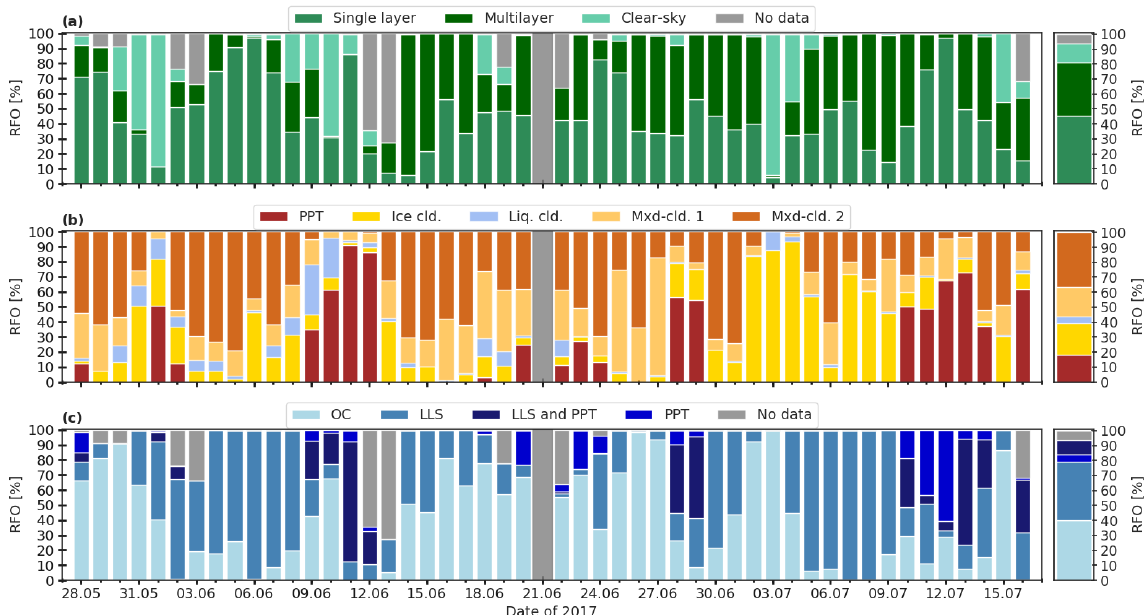
Figure 5. Daily and overall relative frequency of occurrence (RFO) of various cloud characteristics. Panel (a) shows the RFO of clear-sky, single-layer clouds, and multilayer clouds. Panel (b) shows the RFO of the thermodynamic phase of single-layer clouds, differentiating periods of ice clouds, liquid clouds, mixed-phase clouds of type 1 or 2, and precipitation (PPT). Panel (c) is the RFO of various quality flags indicating optimum conditions (OC), low-level stratus (LLS), PPT and simultaneous occurrence of LLS and PPT.